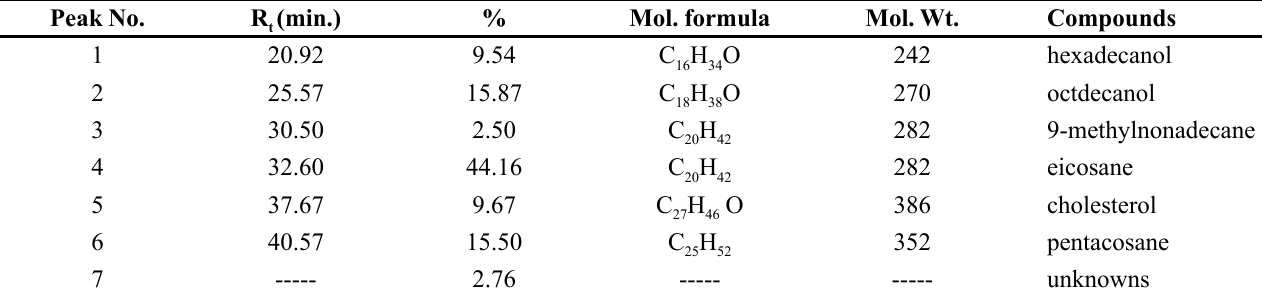
TABLE I - GC/MS analysis of acetone insoluble fraction of Phyllanthus atropurpureus Peak No. R (min.) t